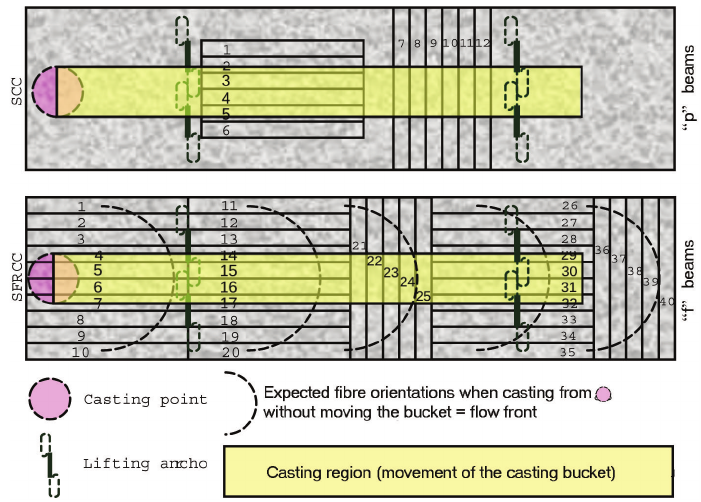
Fig. 2. Beam layout of specimens cut out of the cast plates; SFRCC beams are referred to with “f” and their number, non-fibre beams with “p” and their number.